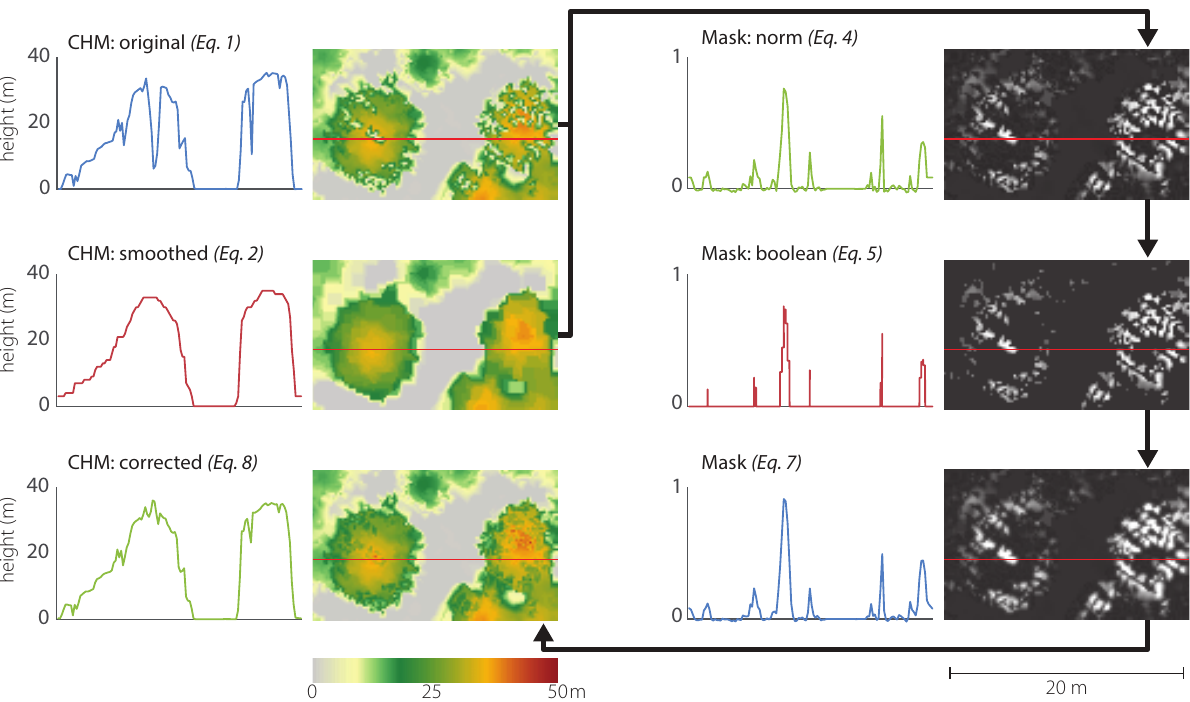
Figure 5. A number of steps were taken to correct the original CHM with artifacts. The horizontal profiles across canopy and ground (right) depict how the mathematical steps altered the raster